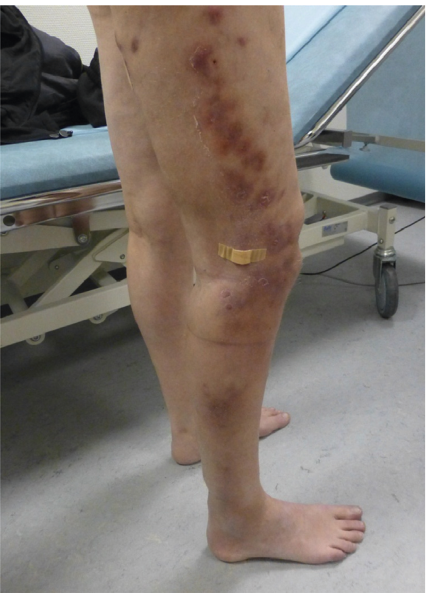
Figure 2: Photography of the patient with bluish red indurated patches of the right lower leg extending up through the lateral part of the thigh, with swelling of the entire right leg. The patient had covered an ulcerating element with band